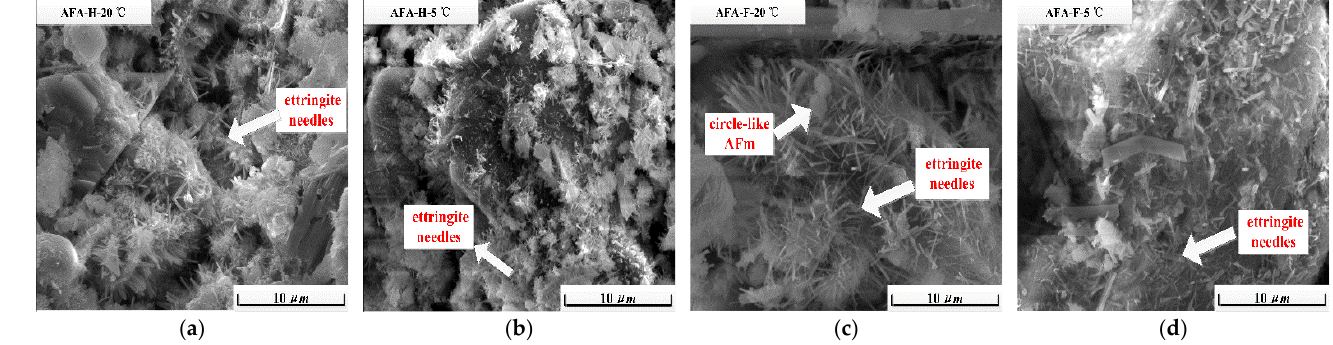
Figure 4. At 15 min of hydration, ESEM images of cement paste containing alkali-free accelerators without ( a , b ) and with fluoride ( c , d ) under 20 °C or 5 °C environment temperatures.